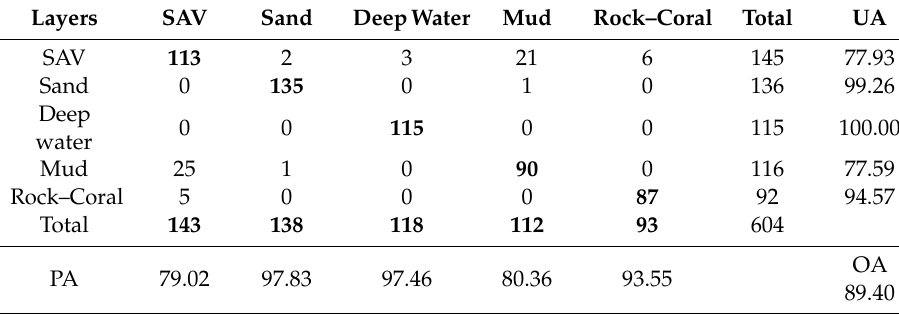
Table A2. VNREDSat-1 confusion matrix table